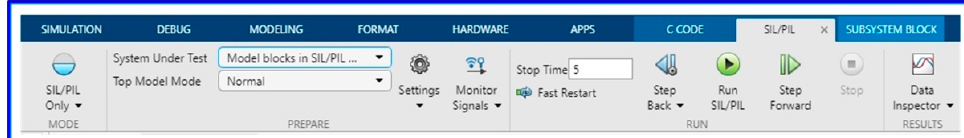
Figure 28. Time evolution of the PMSM rotor speed—PIL stage. Figure 27. Time evolution of the PMSM rotor speed—PIL stage.